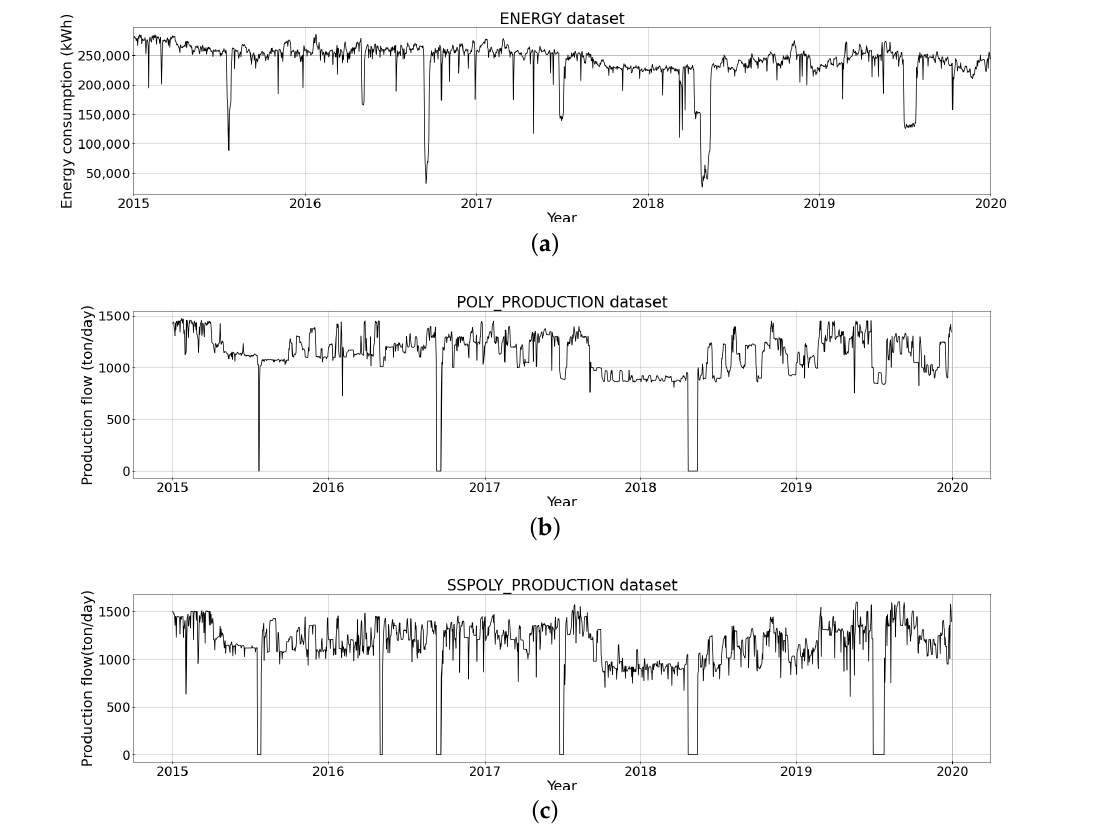
Figure 1. Daily dataset of ( a ) the energy consumption, ( b ) the production flow for the polymerisation stage, and ( c ) the production flow for the solid-state polymerisation